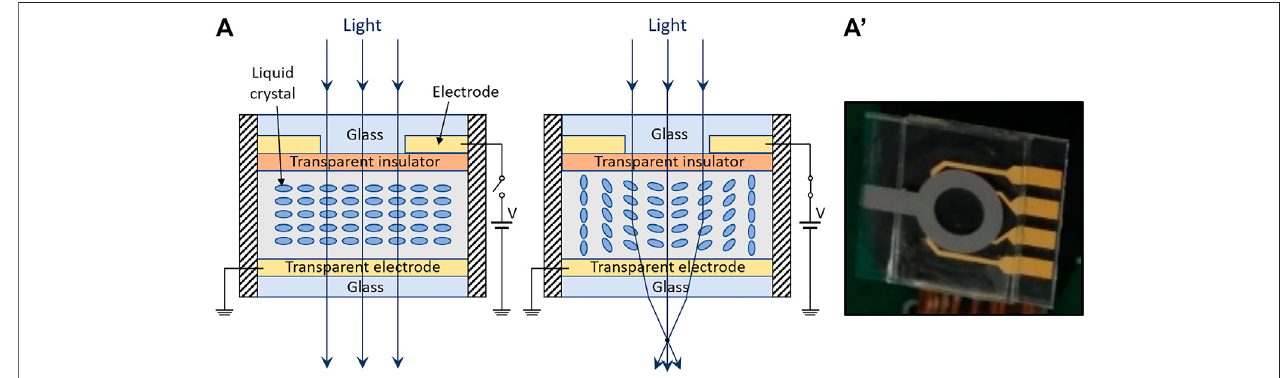
FIGURE2| Liquidcrystallens. (A) Schematicofapossiblestructure(takenasanexampleamongvariousalternatives)andrelatedprincipleofoperation:anapplied voltage creates a non-uniform electric fi eld, which spatially varies the orientation of liquid crystals, causing a non-uniform refractive index and, so, a light focusing effect; (A 9 ) Prototype sample, reproduced with permission from (Allen,